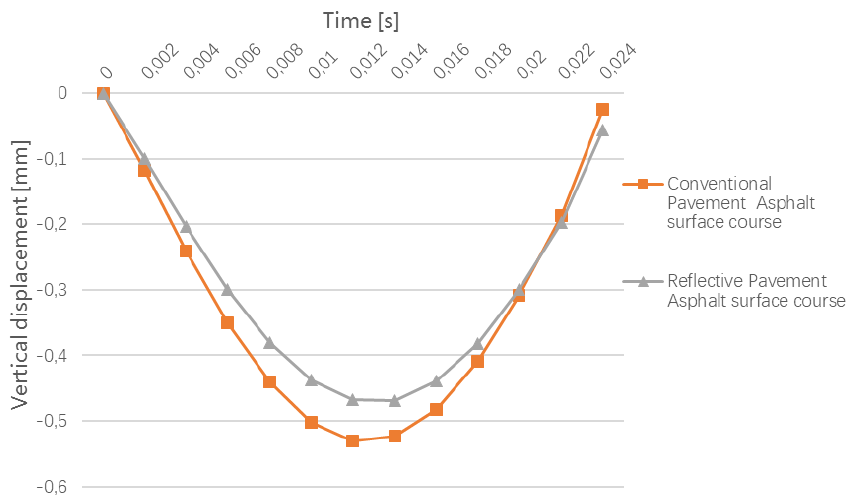
Figure 11. Comparison of the vertical displacement of the conventional pavement and cool pavement at 13 h in the summer.